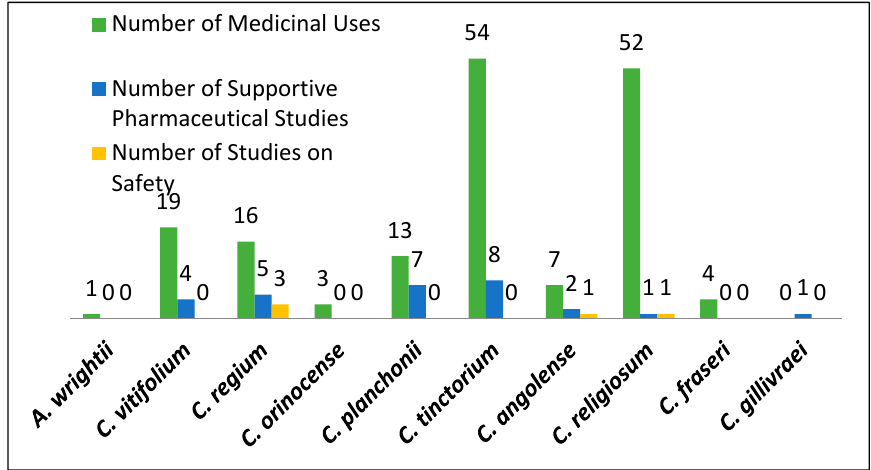
Figure 3. Numbers above bars indicate medicinal uses per species and pharmacological studies that support medicinal activity and safety.